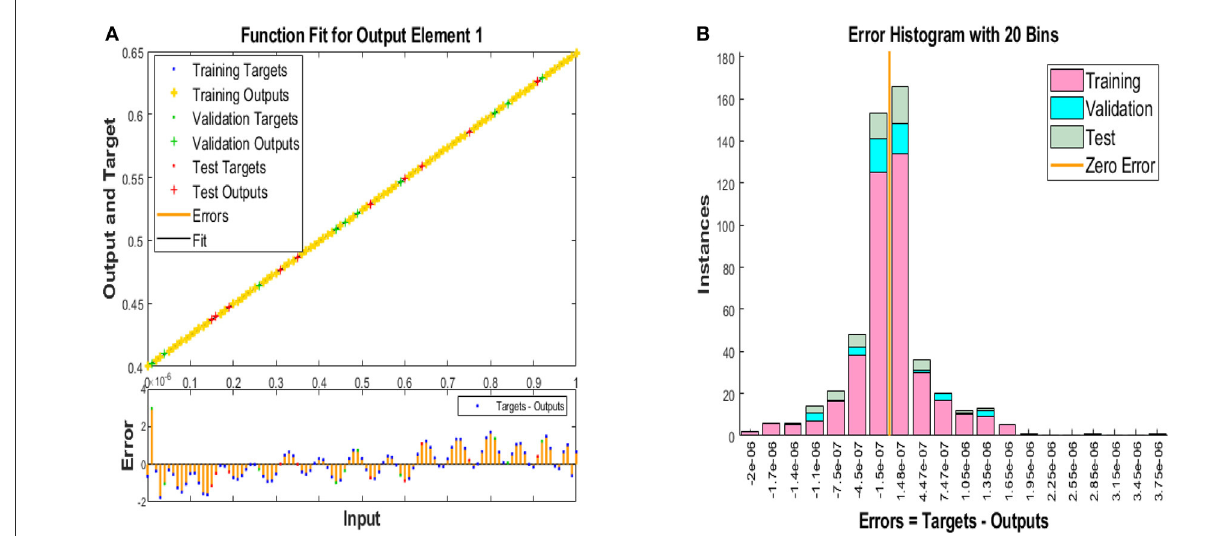
FIGURE3 Results and EHs performances for the HBV system. (A) Results: Case 1. (B) EHs: Case 1.